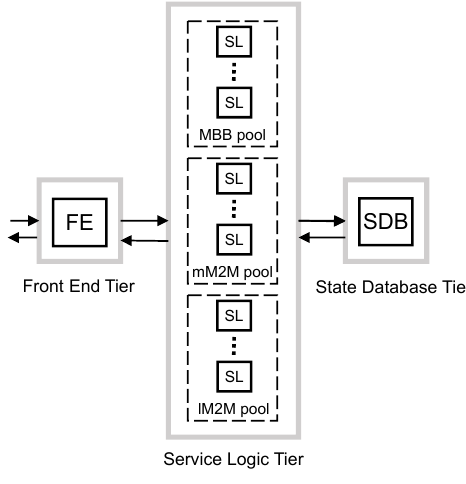
Figure 7. Traffic separated scheme block